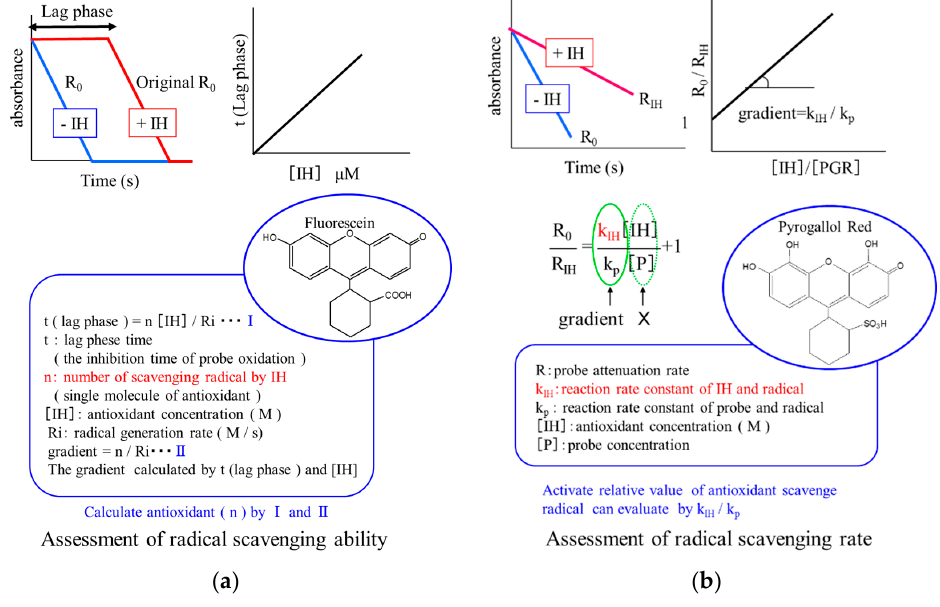
Figure 1. Assessment of ( a ) amount of radicals scavenged by antioxidant (stoichiometric number of antioxidants ( n )) and ( b ) the effectiveness of radical-scavenging (RIH).